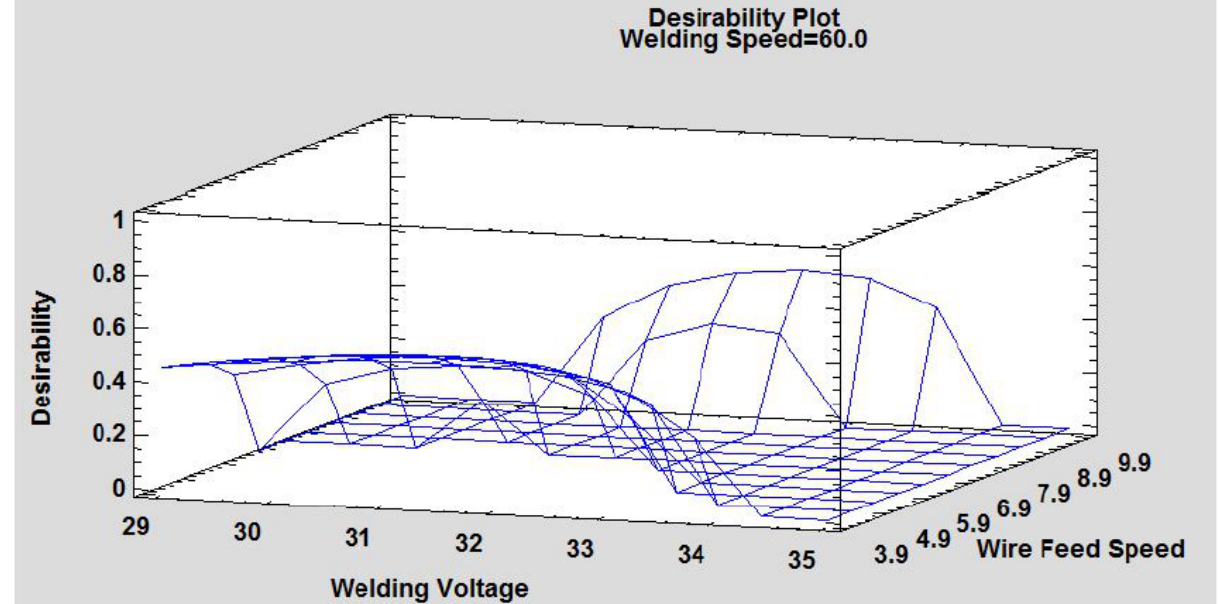
Figure 8. Optimum factors setting at the optimum